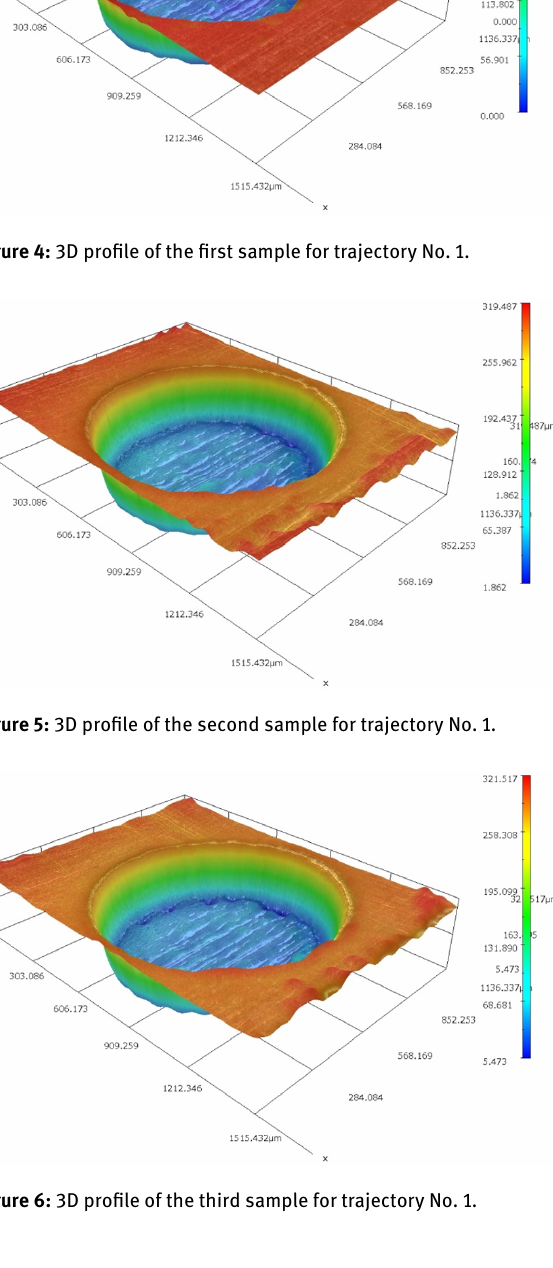
Figure 3: Scheme of the measurement method. Theoutlineofthetop(greenline)andbottom(redline) surface was determined on the basis of approximated aver- age theoretical lines, for which the sum of squares devia- tions is the smallest. Side edge outlines (blue lines) were